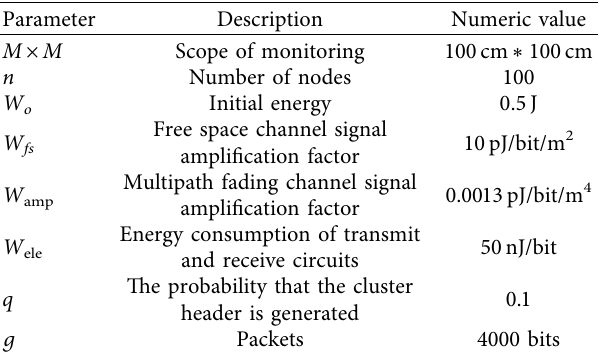
Figure 12: Node distribution diagram in the simulation environment. Table 1: Simulation parameter settings.